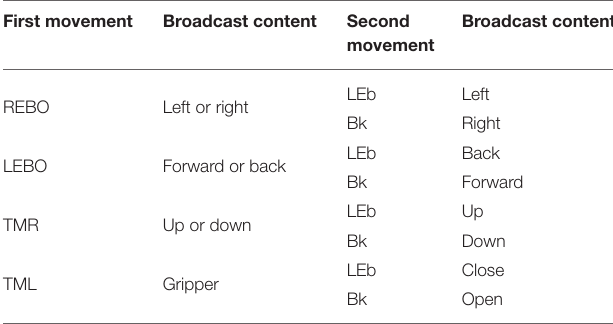
TABLE 2 | Broadcast contents in audio feedback after the first action or the second action is recognized. First movement